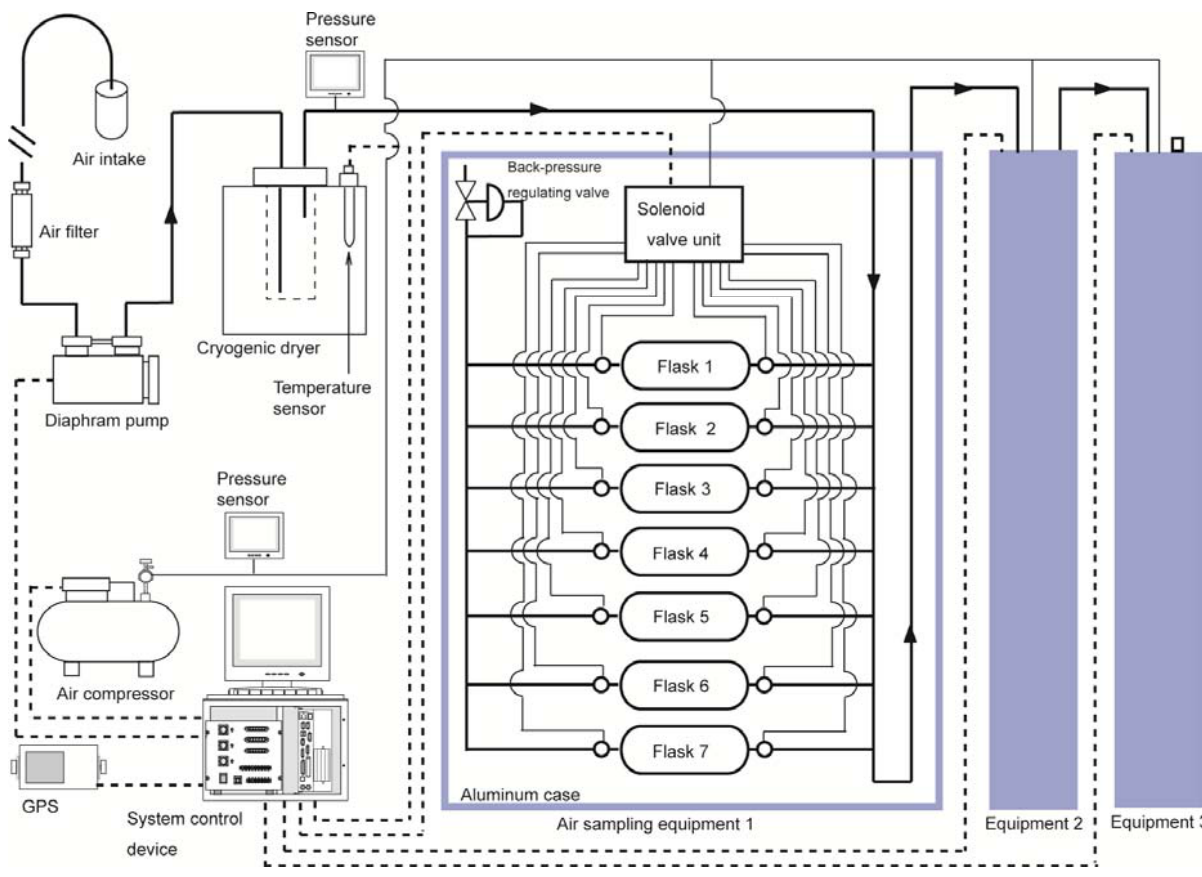
Figure 2. Schematic diagram of a flask sampling system for the NIES VOS program. Thick and thin solid lines denote lines for sample and compressed air respectively. Thick dashed lines denote the electric wiring that connects the system control device with discrete components of the system.